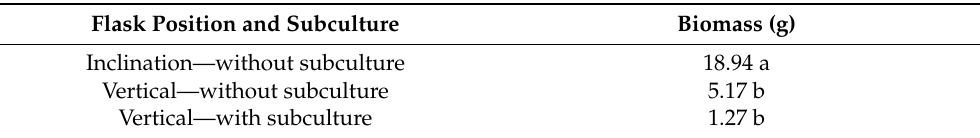
Means with the same letter are not statistically different (Tukey α = 0.05).